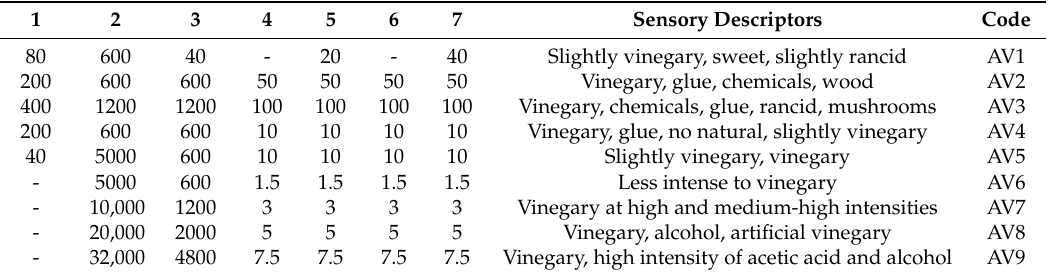
Table 3. Main formulations (volatile compounds and concentrations in mg / kg)